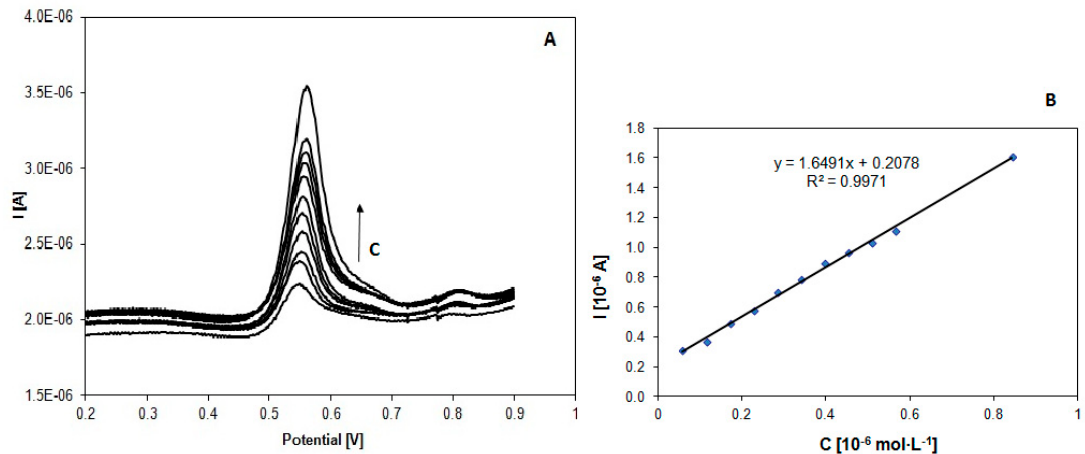
Figure 7. SWV voltammograms of different concentrations of posaconazole in B-R buffer pH 4.35 (range of concentration 5.7 × 10 − 8 –8.44 × 10 − 7 mol · L − 1 ) ( A ); Calibration curves of posaconazole using SWV methods, on the BDD electrode ( B ).